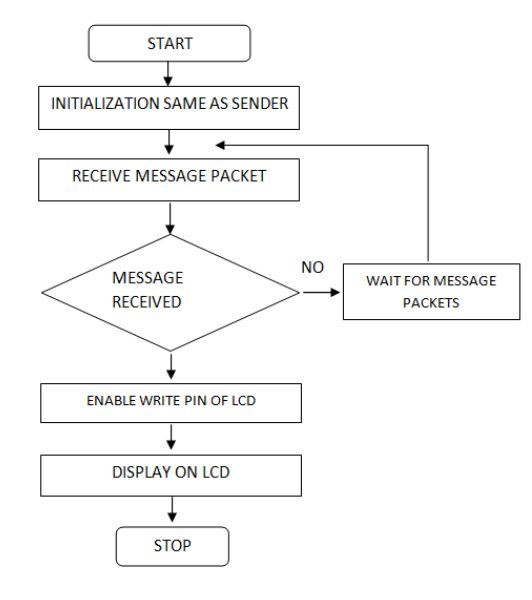
Fig. 5. Steps for LoRa reception